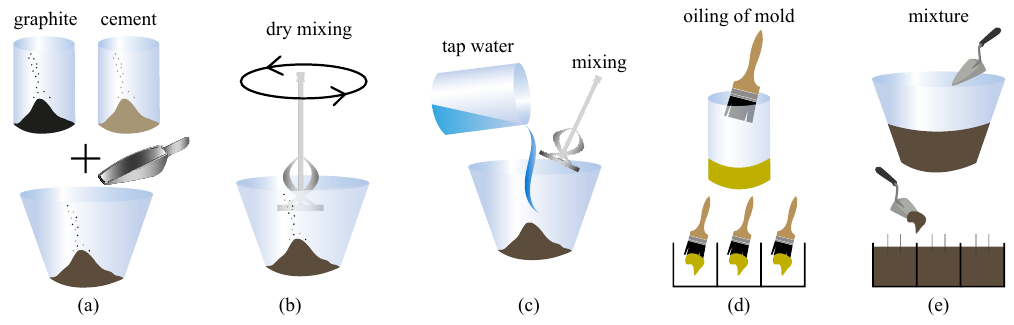
Figure 1. The production steps of the cement–graphite composite samples: ( a ) adding graphite and cement; ( b ) mixing the compounds in their dry powder form; ( c ) adding water and mixing until homogeneity; ( d ) preparing molds; ( e ) casting compound into the molds and electrodes.